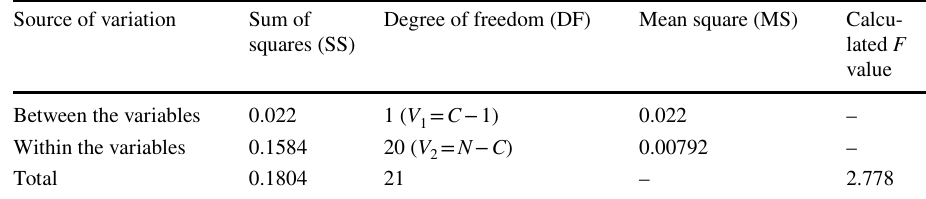
Table 5 Result of ANOVA test